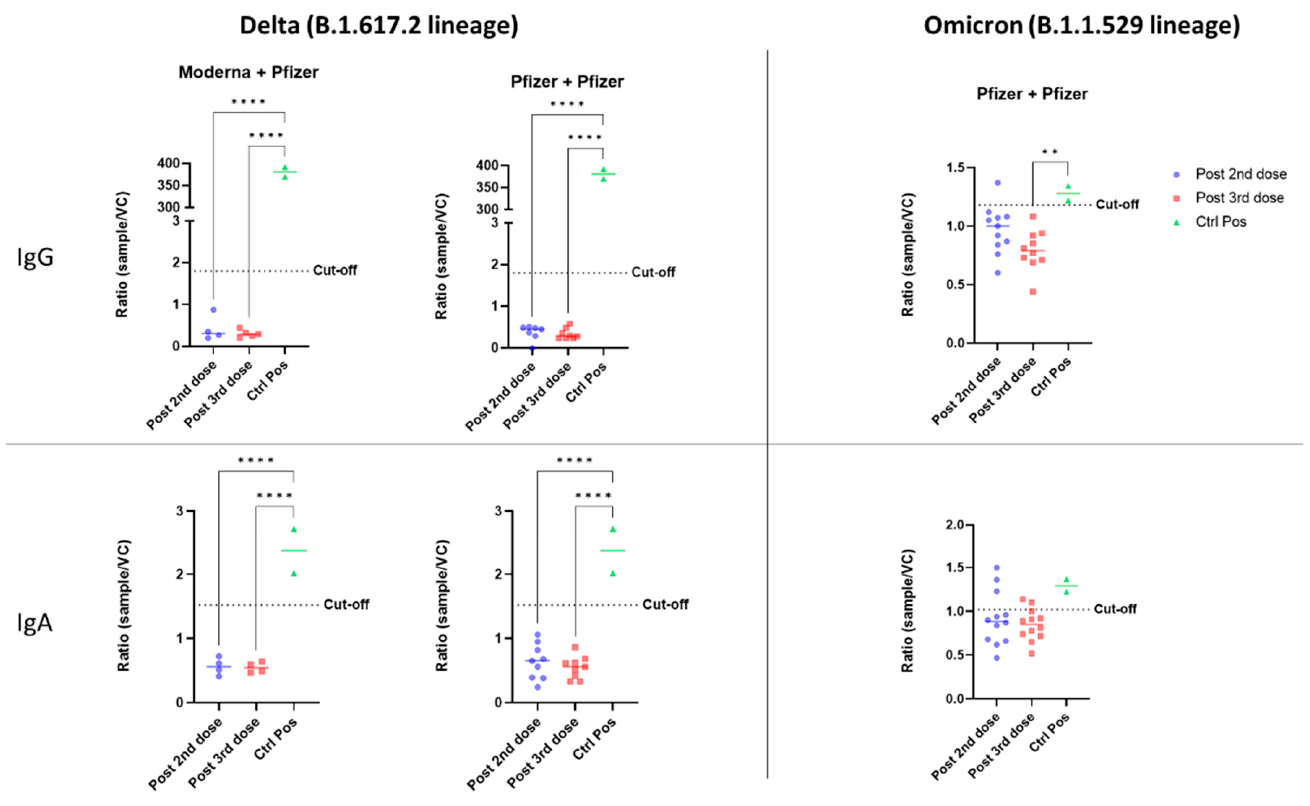
Figure 2. In vitro ADE of SARS-CoV-2 infection from individuals vaccinated with different vaccina- tion schemes (heterologous: Moderna/Pfizer; or homologous: Pfizer/Pfizer). The ADE effect was evaluated with the Delta and Omicron variants, and the involvement of IgG and Ig A antibodies was assessed using HEK-293 CD16+ or CD89+ cells. Viral quantification was measured by a SARS-CoV-2- specific RT-PCR. The ratio of the amount of virus for each sample to that for a viral control without serum (sample/CV) is shown. Each dot corresponds to a single patient. An anti-RBD IgG was used as a positive control for the CD16 test, and an anti-S IgA was used for CD89. Sera were used at a 1:100 dilution. The cut-off was determined as the mean for eight pre-pandemic serum samples plus two standard deviations. The statistical significance of differences between groups in ANOVA with Tukey tests for multiple comparisons is shown for each set of conditions (** p < 0.01, **** p < 0.0001).